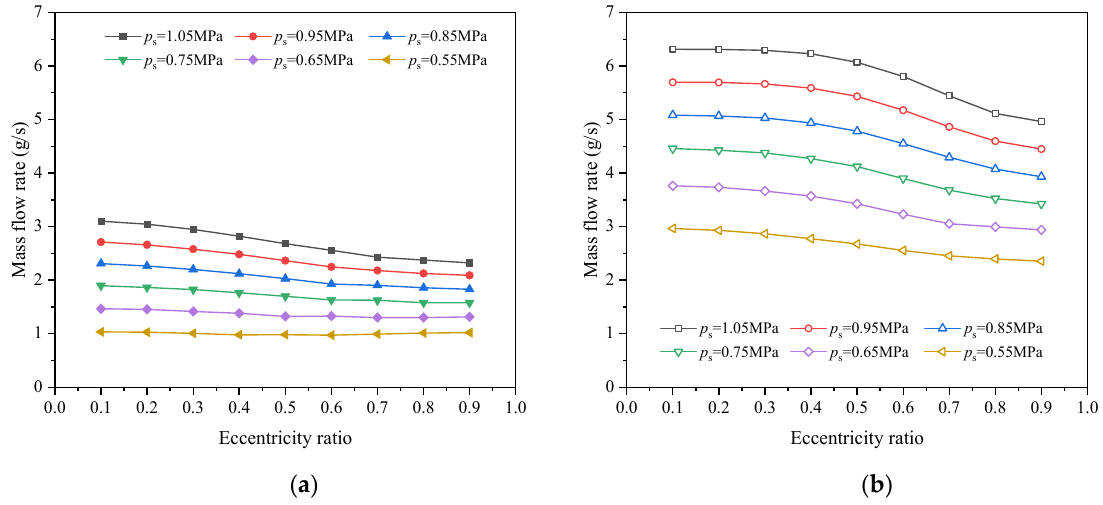
Figure 11. Mass flow rate variation with eccentricity ratio under different supply pressures ( d = 0.3 mm, h 0 = 25 μ m) ( a ) air ( b ) R134a.